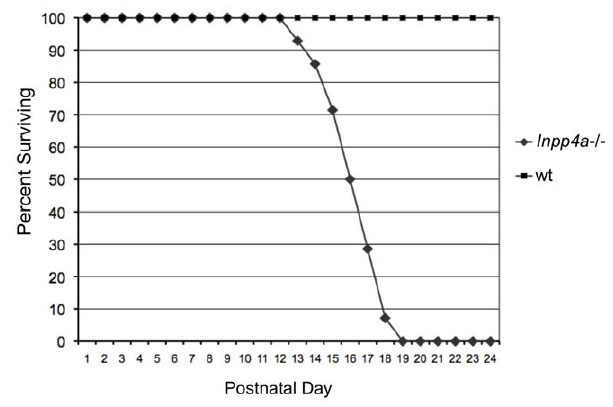
Figure 1. The Inpp4a wbl mutant phenotype causes pre-wean mortality. A Kaplan-Meier survival curve showing the lifespan of Inpp4a wbl mutants on the BALB/cJ background, n=20, no heterozygous or wild-type pups were lost. Percent survival is plotted on the y-axis versus postnatal day on the x-axis.